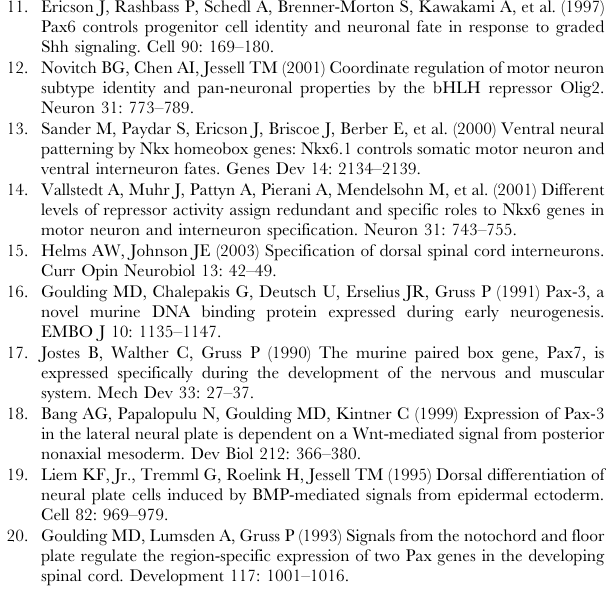
Figure S6 The conservation of CNE1 across vertebrate